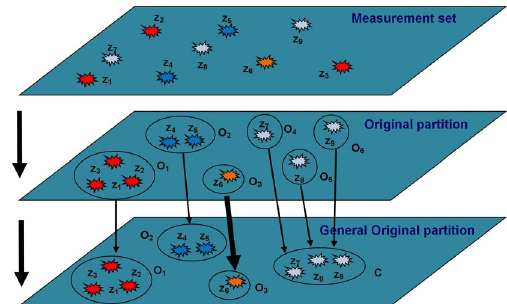
Fig. 3 General original partition